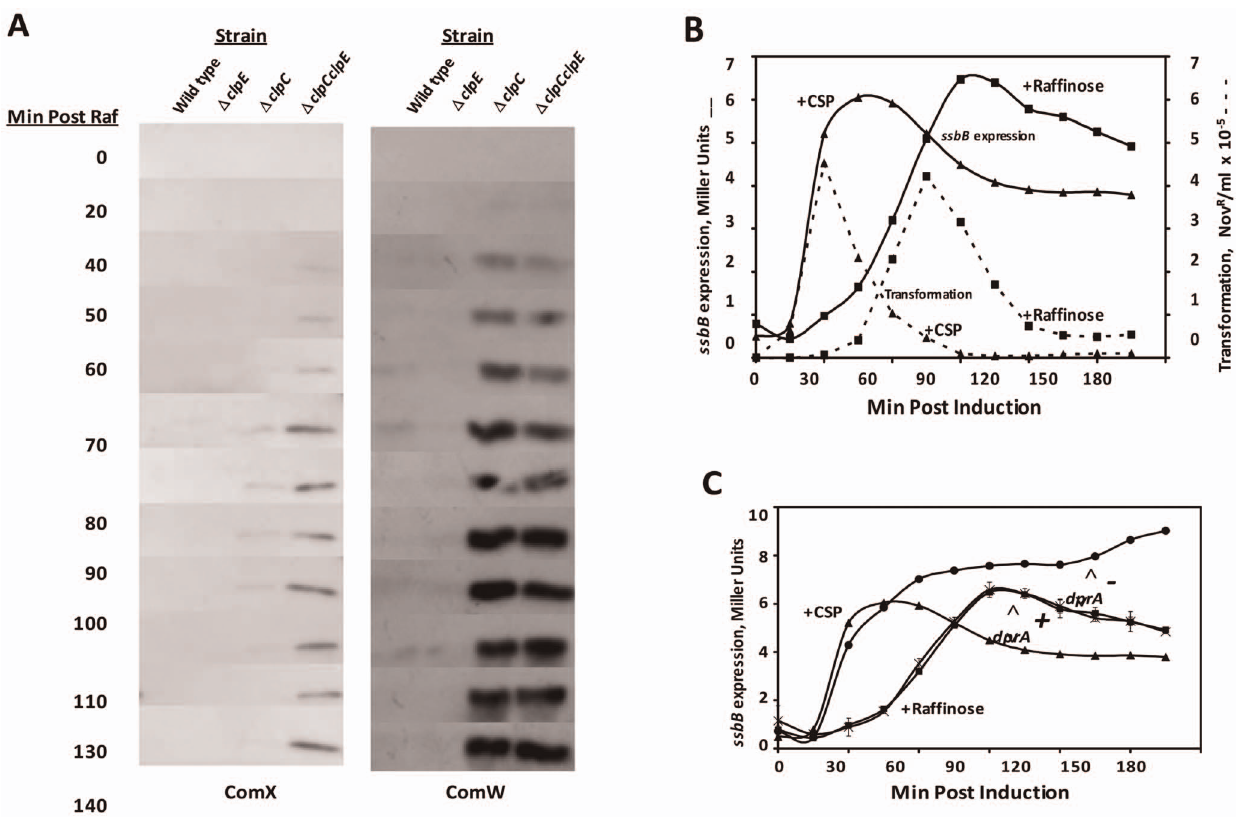
Figure 7. Lack of effect of DprA on late gene expression in an ectopic comXcomW strain. A. Western blot analysis of samples taken at different times after induction with raffinose. Wild type, CP1896 ( aga::comX::comW ); D clpE , CP1962 (CP1896, but D clpE ); D clpC , CP1963 (CP1896, but D clpC ); D clpE D clpC, CP1964 (CP1896, but D clpE D clpC ). B. Kinetics of competence induction and late gene expression induced with either CSP ( D ) or raffinose ( % ). During treatment of CP1902 ( aga::comX::comW , ssbB::lacZ, D clpC , D clpE ,) with either CSP (250 ng/ml) or raffinose (0.1%) at 30 u C, samples were taken in parallel, to monitor transformation (–) and a -gal activity (–). b -gal activity is expressed in Miller Units with respect to the OD of the N culture at each time point. C . Late gene expression of CP1902 treated with either CSP ( D ) or raffinose ( % ) or CP1932 (CP1902, D dprA ) with either CSP ) or raffinose (x) at as 30 u C for B. (